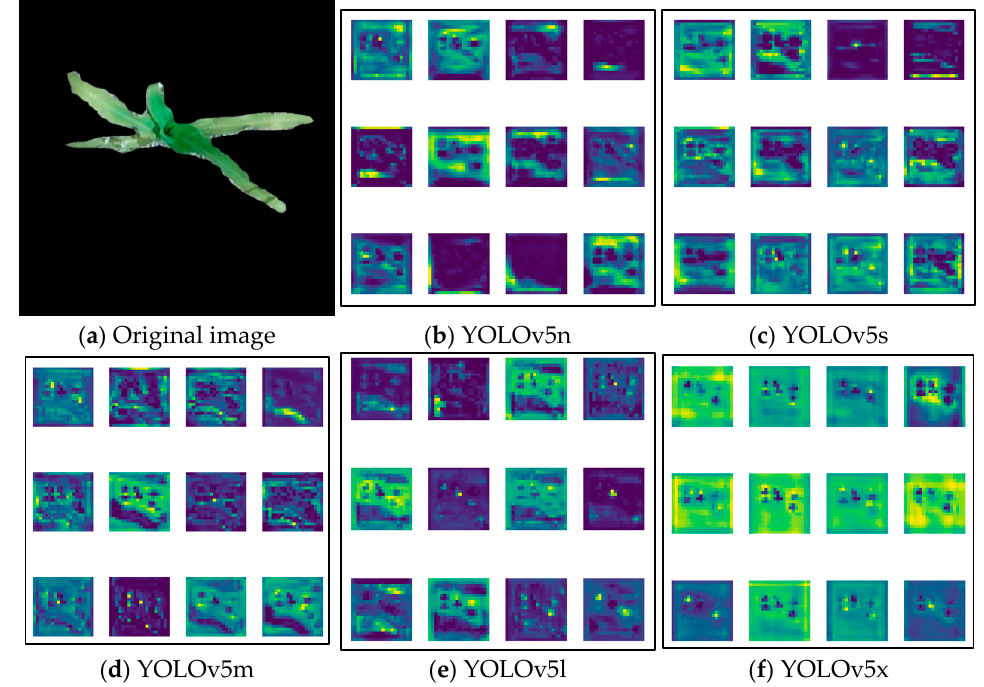
Figure 9. Visualization of the YOLOv5 stage23_C3_features feature map. ( a ) Original image; ( b – f ) stage23_C3_features feature maps of the five networks. ( b – f ) stage23_C3_features feature maps of the five